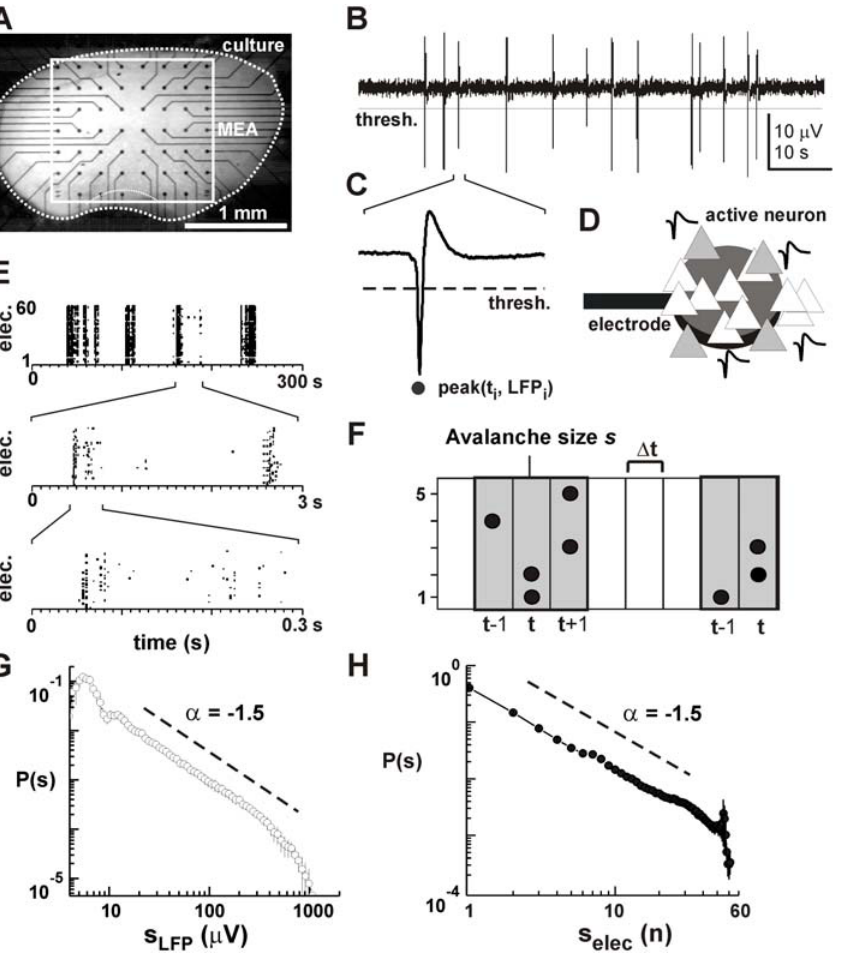
Figure 7. Neuronal avalanches in organotypic cortex cultures recorded with integrated planar micro-electrode arrays (MEA). (A) Light microscopic image of an organotypic culture from rat somatosensory cortex grown for 12 days on an MEA (square). Electrode positions are visible as an 8 6 8 dot matrix with connecting leads attached. (B) Spontaneous activity at a single electrode is characterized by the occurrence of large deflections in the local field potential (LFP). (C) A single LFP deflection at higher temporal resolution taken from (B). The negative peak deflection (nLFP) that crosses a negative threshold (broken line) is characterized by its peak amplitude nLFP t ð Þð Þ and peak time t . (D) The nLFP can be interpreted as the local synchronized activity of a subgroup of active neurons (gray triangles) recorded by a nearby electrode (disc). (E) nLFPs on the MEA are clustered into periods of high activity separated by periods of relative quiescence (top), an organization that repeats at higher temporal resolutions (middle and bottom). (F). Sketch of the definition of neuronal avalanches using 5 electrodes on the MEA. A neuronal avalanche arises from the concatenation of successive time bins of width D t that contain at least one nLFP. (G,H) Power law in avalanche size distribution with slope of 2 1.5 for sizes expressed in summed absolute nLFP amplitudes (left) or number of active electrodes, i.e. nLFPs (right; n ~ 7 networks; recalculated from